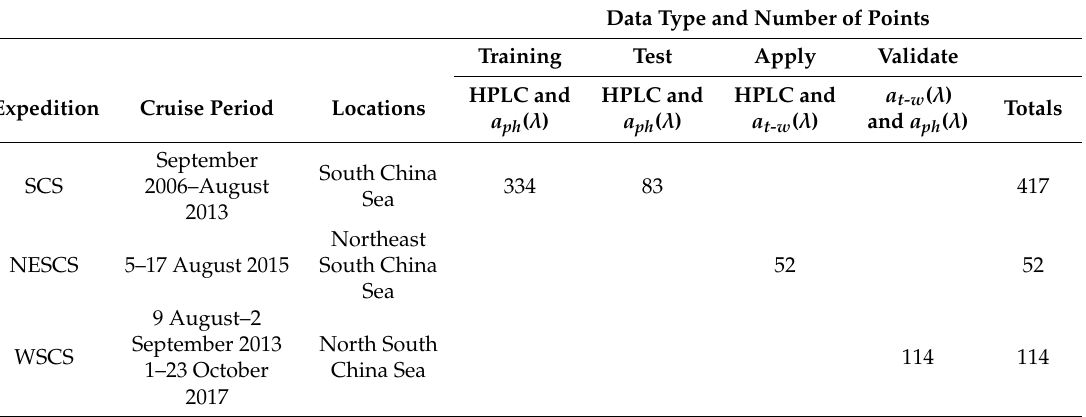
Table 1. Summary of datasets used in this